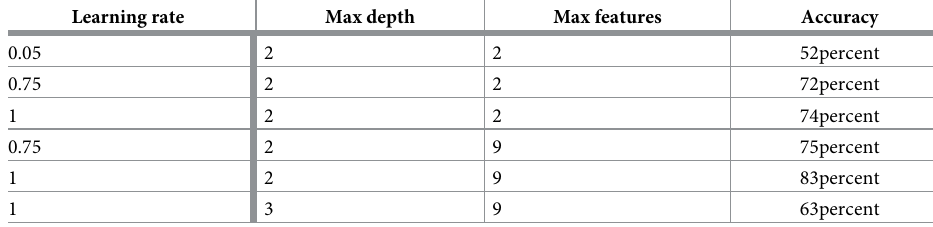
Table 6. Gradient Boost results after parameters